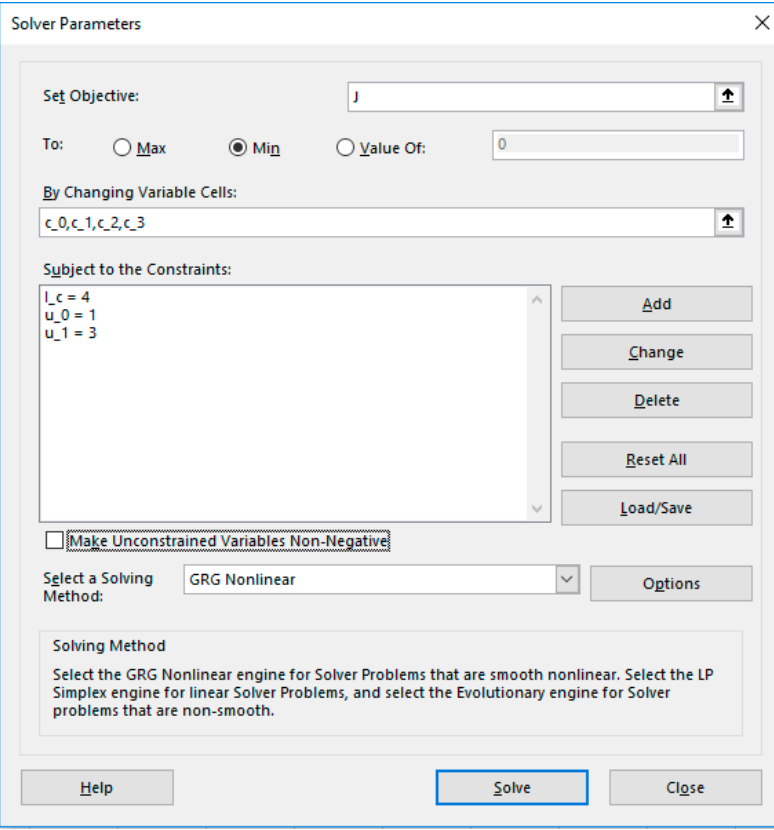
Figure 3. Input to Excel solver for problem 3.1 based on the spreadsheet model in Figure 2.